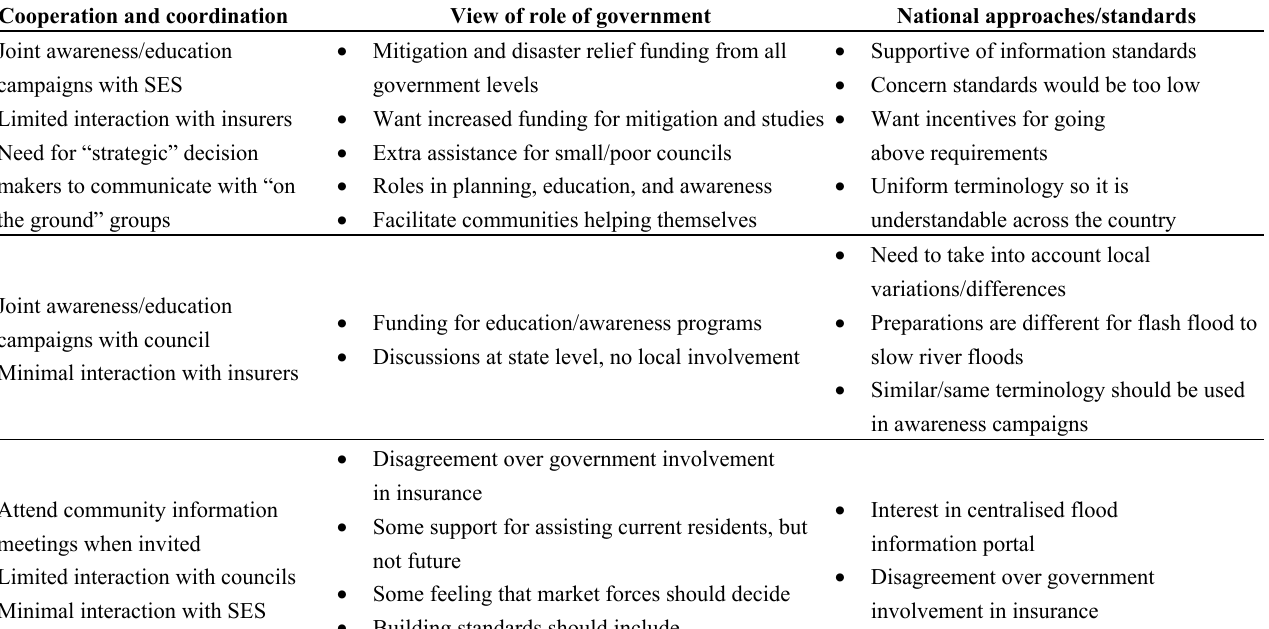
Table 3. Concepts and themes of responsibility from